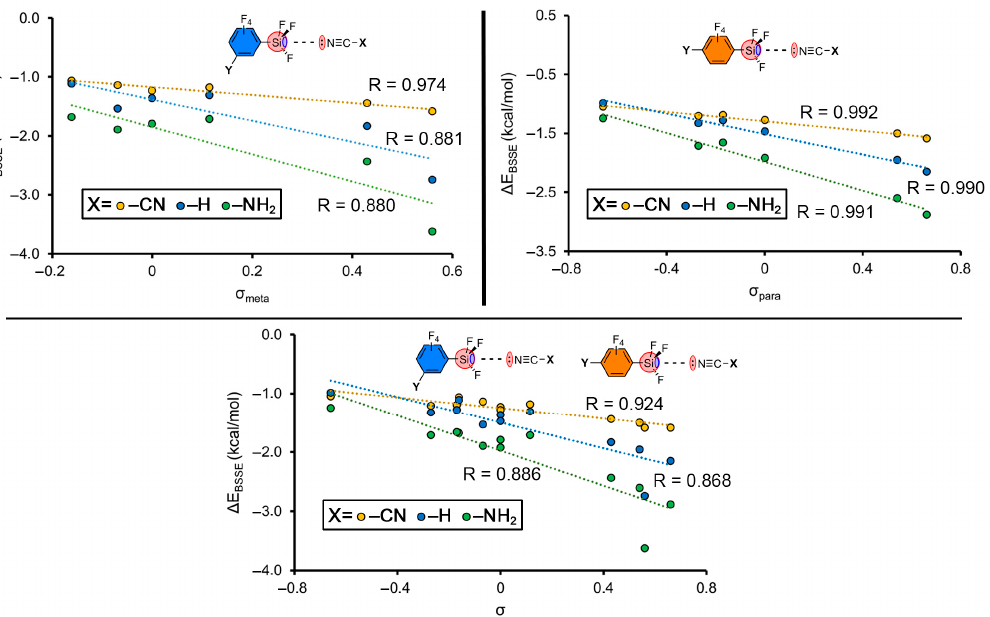
Figure 5. Hammett’s plots ( Δ E BSSE vs. σ ) of meta- and para-substituted complexes involving –CN, –H, –NH 2 groups (top left and right, respectively). Hammett’s plots ( Δ E BSSE vs. σ ) including meta- and para-substituted complexes in the same representation (bottom).